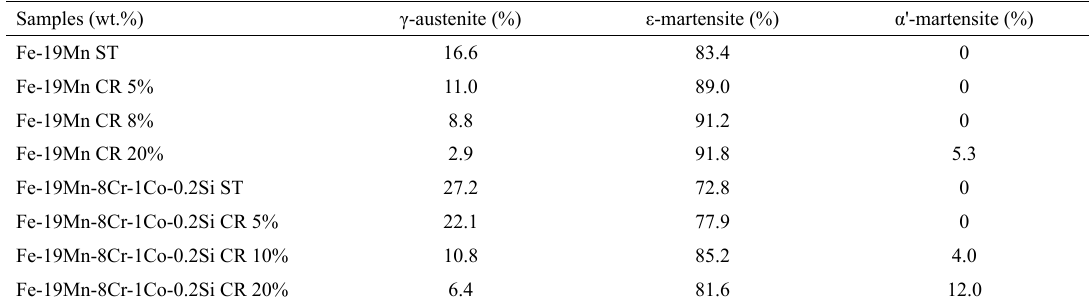
Table 2. Volume fractions of each phase after solution treatment (ST) and cold rolling (CR). Samples (wt.%)